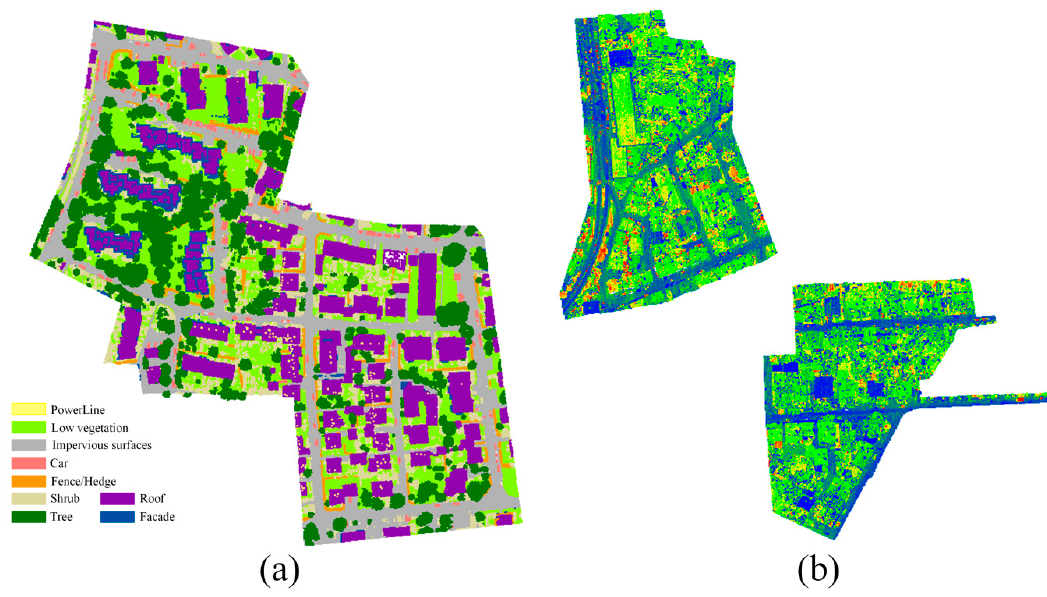
Figure 7. International Society for Photogrammetry and Remote Sensing (ISPRS) dataset: ( a ) training dataset displayed by label, ( b ) testing dataset displayed by intensity.